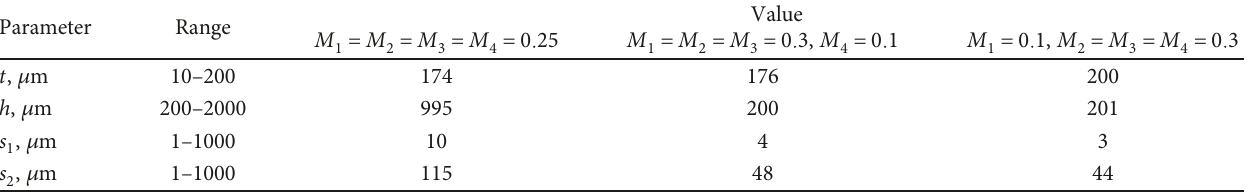
Table 7: Optimized parameters of MF for N = 3 , their ranges, and values after optimization with di ff erent weighing coe ffi cients. Parameter